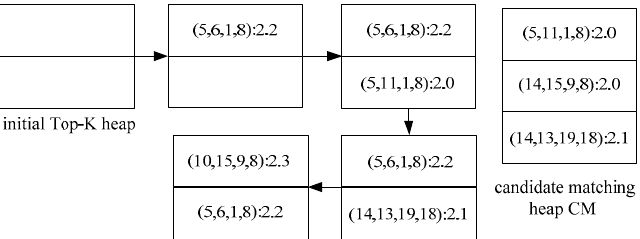
Figure 7. The change process of initial Top-K heap and the candidate matching heap CM.